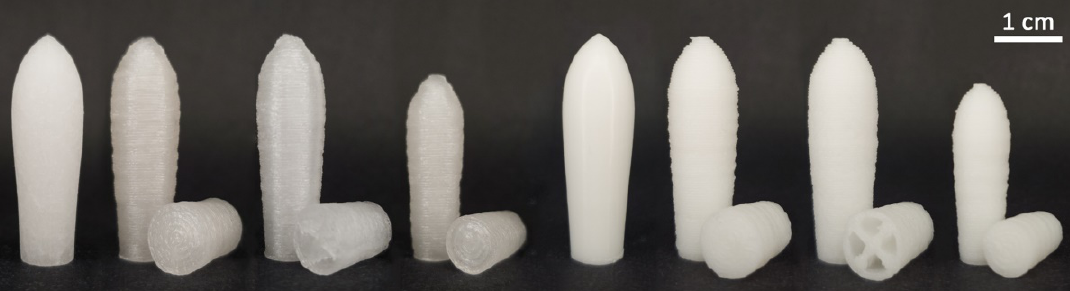
Figure 4. Photographic images of molded and 3D printed suppositories containing 10% ( w / w ) paracetamol in the frontal view and internal view of partially printed suppositories. From left to right: PEG mold, PEG “standard”, PEG “hollow”, PEG “small”, HF mold, HF “standard”, HF “hollow”, HF “small”.